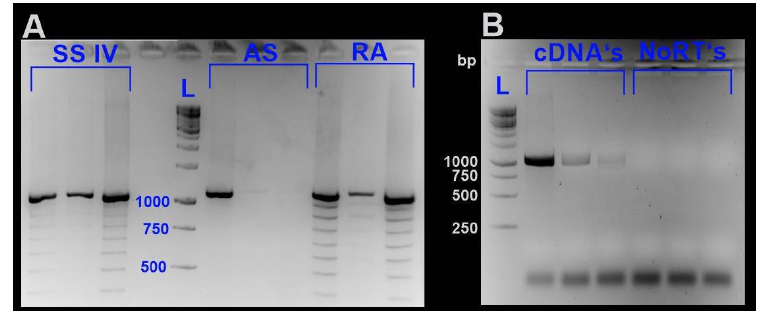
Figure 9. Gene-specific LD-PCR of the md-MTs using cDNA templates generated by three different reverse transcriptase systems. ( A ) PCR products using cDNAs as a template, which were generated by three different reverse transcriptases, namely, SuperScript TM IV (SSIV), AccuScript High Fidelity (AS), and RevertAid H Minus (RA). ( B ) Shows PCR products using cDNAs generated by reverse transcription with AccuScript High Fidelity. In addition, the respective NoRT’s (see Section 3.6) are shown as a negative control to exclude contamination of the cDNAs with genomic DNA. Abbreviations: L., ladder.